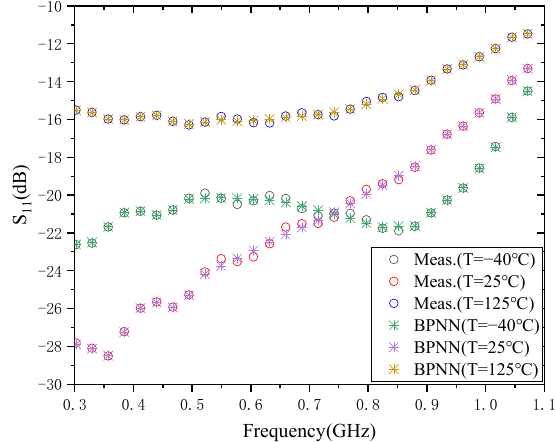
Figure 3. Modeling results of S 11 .